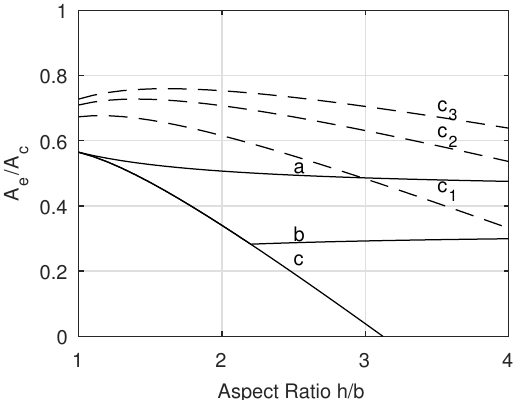
Figure 2. Effective confinement area ratio vs. aspect ratio: ( a ) Lam and Teng [10], Vuggumudi et al. [32]; ( b ) Maalej et al. [27]; ( c ) Tan [20], Triantafillou et al. [31]; ( c 1 – c 3 ) Tan [20], Triantafillou et al. [31] for 1, 2, and 3 internal links,